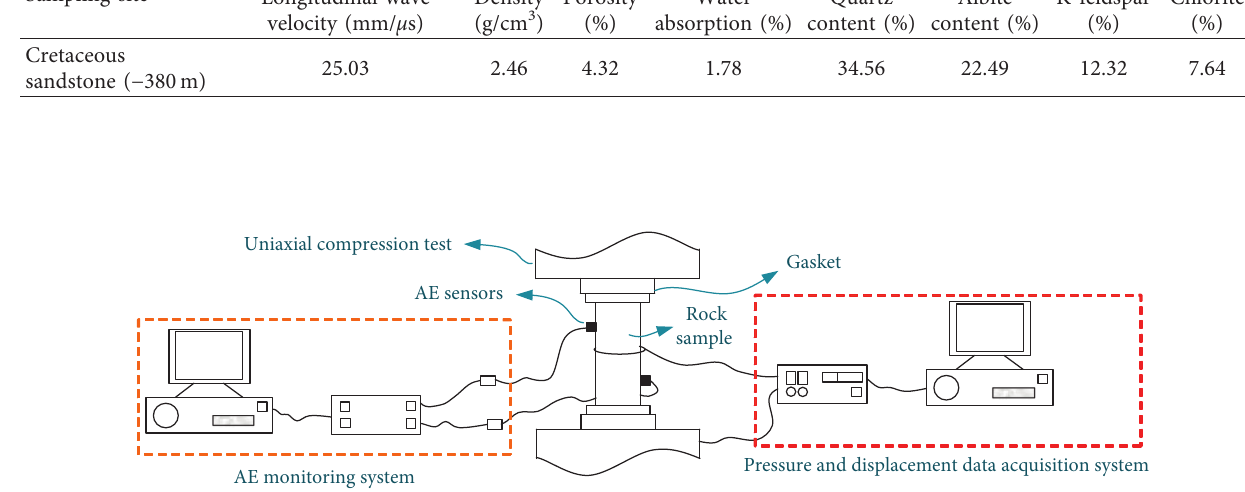
Figure 1: Schematic diagram of the experimental